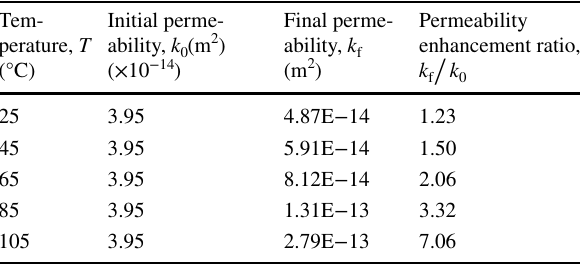
Table 3 Effect of temperature on permeability enhancement ratio